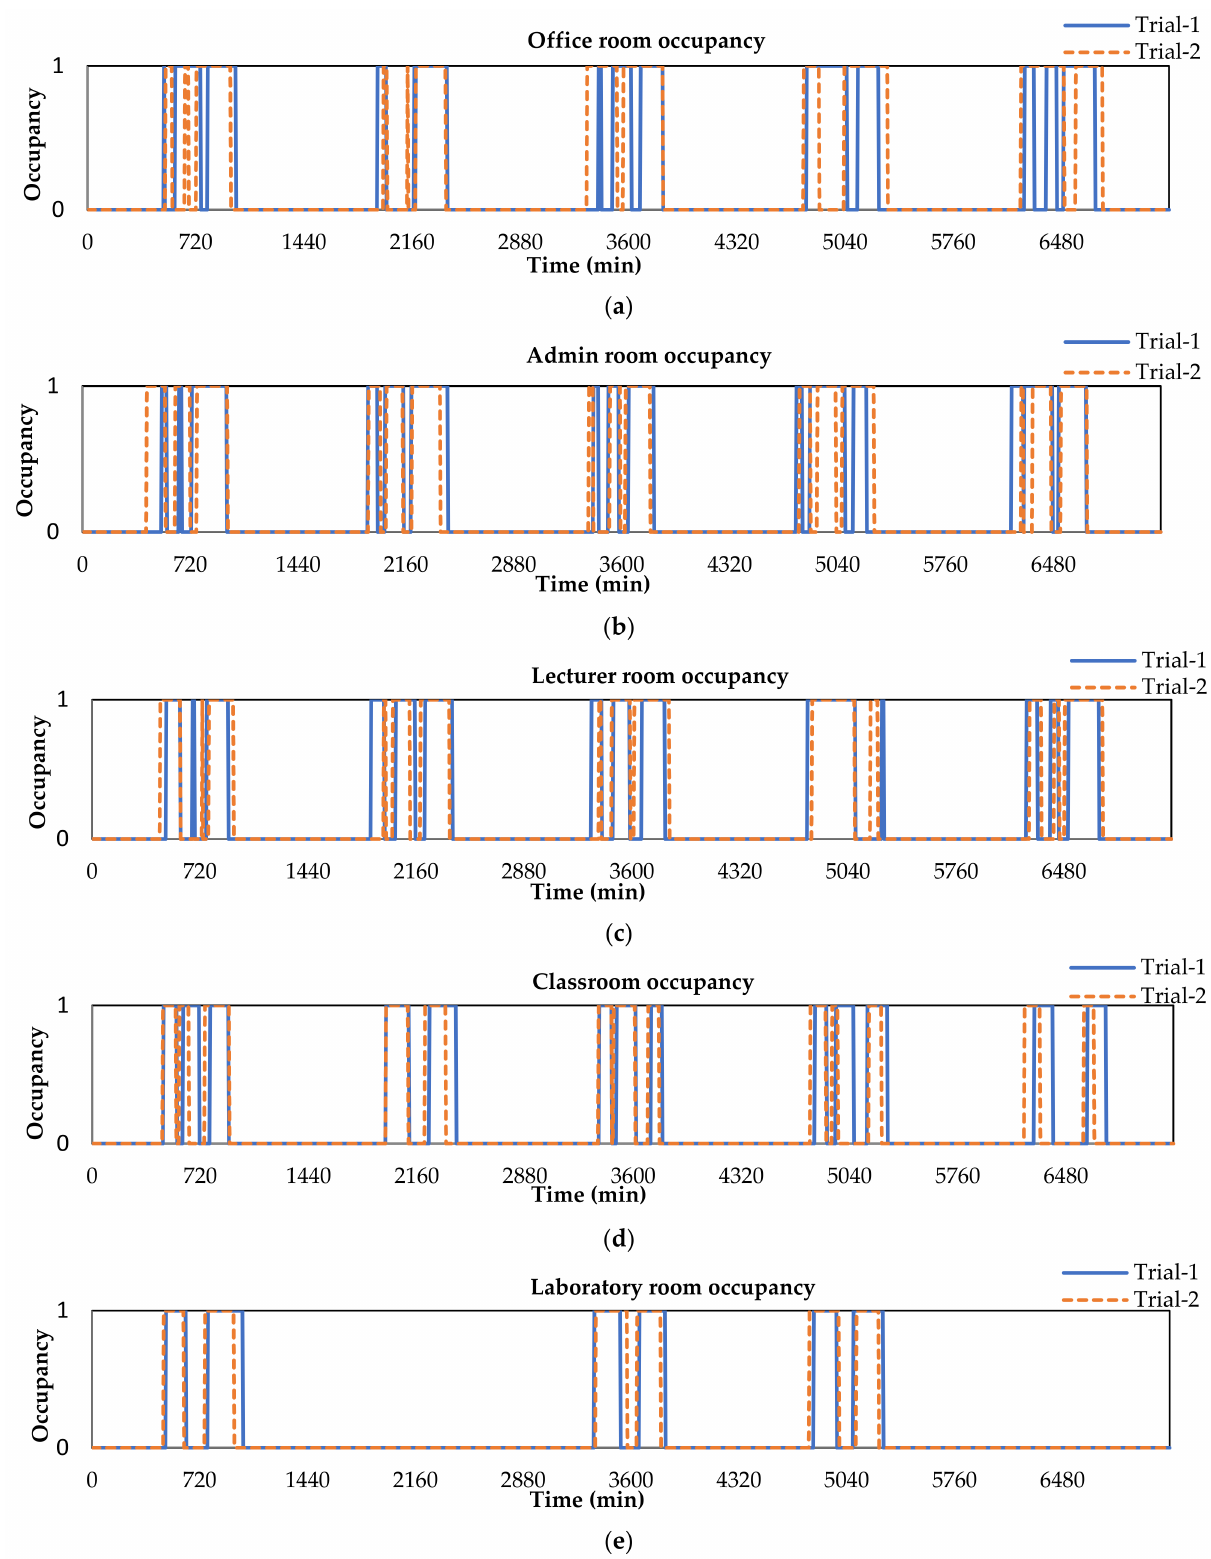
Figure 10. Simulation results of the occupancy model: ( a ) Office room; ( b ) Administration room; ( c ) Lecturer room; ( d ) Classroom; ( e ) Laboratory